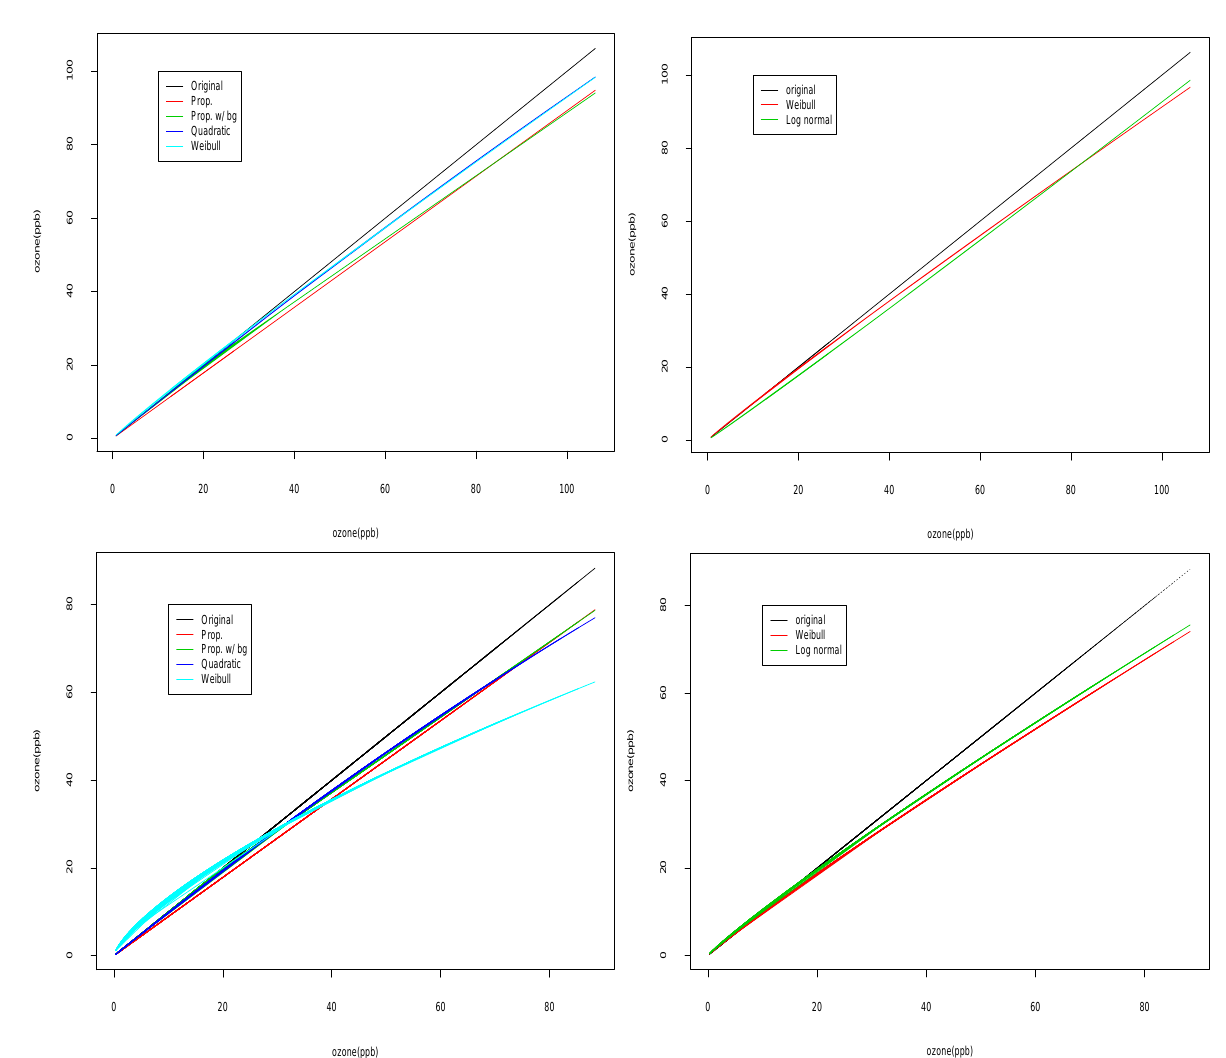
Figure 2. Q-Q plots based on various rallback functions ( left ) and statistical rollbacks ( right ) based on ozone data in New York ( top ) and Detroit ( bottom ) during